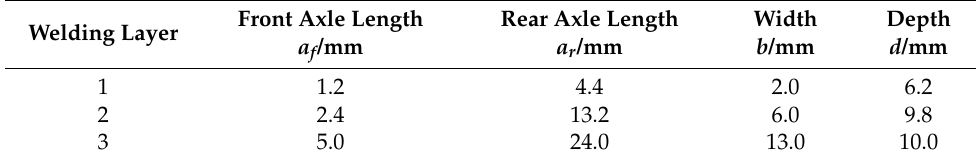
Table 2. Heat source parameters.